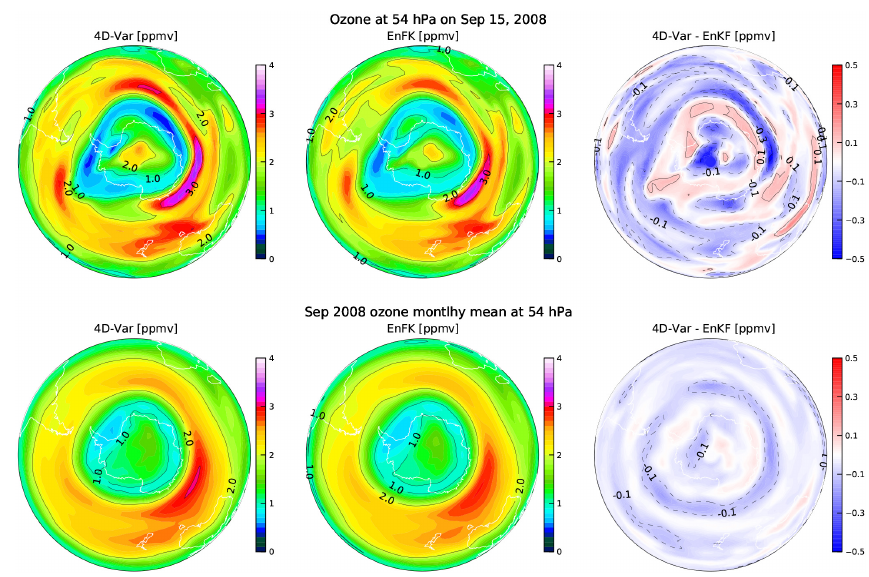
Figure 7. Ozone at 54.6hPa (model level 22) from 4D-Var (left), EnKF (middle) and their absolute differences (right). The upper row corresponds to a snapshot on 15 September 2008 while the lower row corresponds to a monthly mean for the month of September